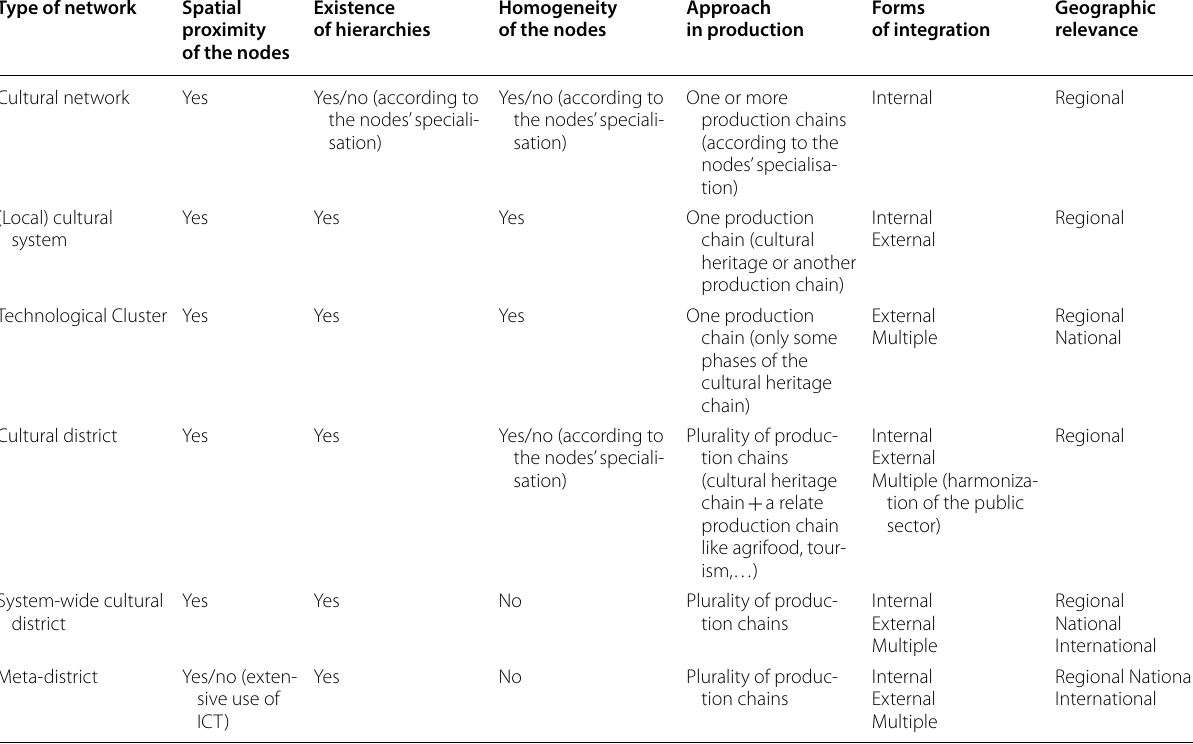
Table 10 Cultural networks working under the umbrella concept of cultural district: a classification based on the relational and organisational features. Source: elaboration of the authors Type of